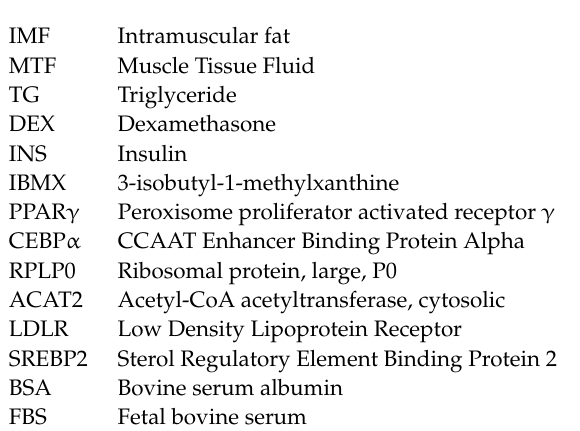
proliferation; Figure S2: Muscle tissue fluid of pig with high intramuscular fat level had no effect on pig intramuscular preadipocytes differentiation; Figure S3: Data detected by proteomic